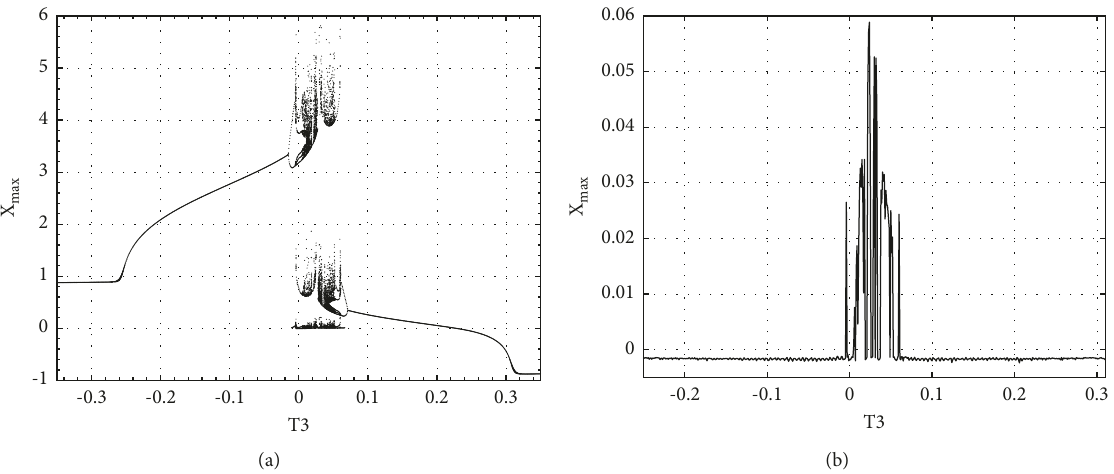
Figure 13: Bifurcation diagram and the local maximum exponent of the motor when the load torque is a square waveform. F � 1 Hz ; initial conditions ( x0 � 0.01; y0 � 0.01; z0 � 20) ; c � 30; u � 0.009; v � 0.005; beta � 0.03; σ � 3.05.